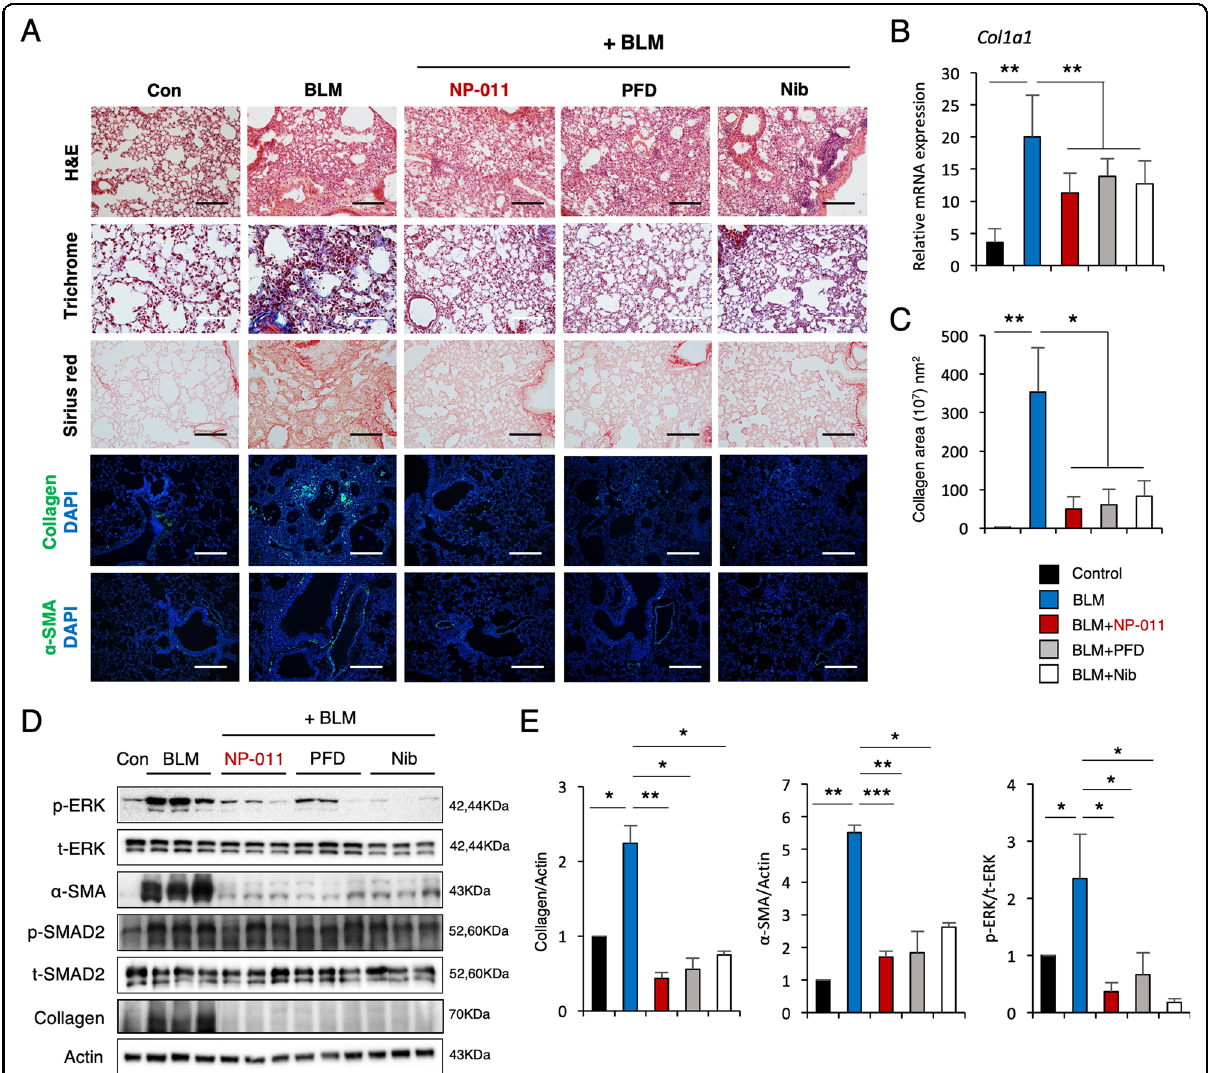
Fig. 3 Comparison of the therapeutic effects of NP-011, PFD, and Nib on BLM-induced PF in mice. A H&E, Masson ’ s trichrome, and Sirius red staining of representative lung sections from each group of treated mice. The effects of NP-011, PFD and Nib on the expression of collagen and α - SMA in lung tissues of BLM-induced PF in mice. Scale bars, 100 μ m. B qPCR analysis for Col1a1 expression. C Quanti fi cation of collagen-positive areas as measured by confocal microscopy. D Whole lungs from control or BLM-challenged mice treated with NP-011, PFD, and Nib were used for Western blotting using p-ERK, Collagen, α -SMA, and a loading control (Actin). E Quanti fi cation of p-ERK, Collagen, and α -SMA. Data are presented as means ± SD; n = 6 (control), n = 8 (BLM), n = 7 (BLM + NP-011), n = 6 (BLM + PFD), n = 8 (BLM + Nib). * p < 0.05, ** p < 0.01